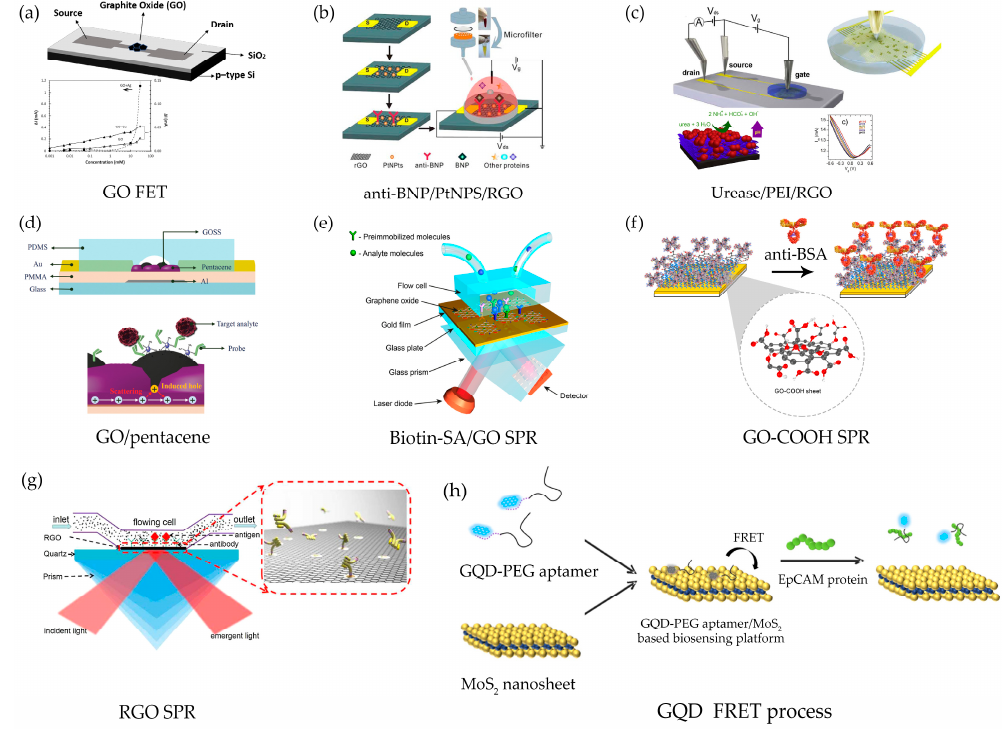
Figure 8. Schematic illustration of functionalized graphene-based biosensors: ( a ) a glucose detection based on GO FET (reprinted with permission from [111]); ( b ) DNA detection based on printing GO/pentacene FET (reprinted with permission from [110]); ( c ) urea platform biosensor based on Urease/PEI/RGO FET (reprinted with permission from [112]); ( d ) Heart failure